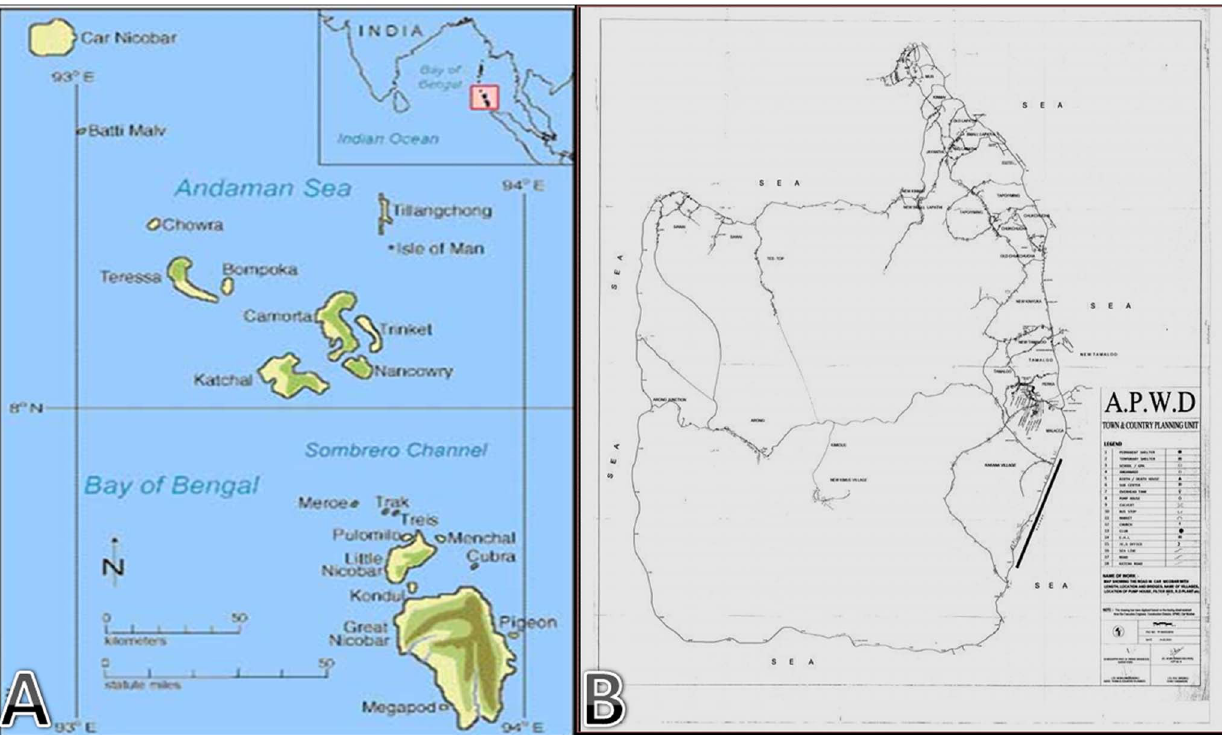
Figure 1. Location of the survey area. A) Map of Southern India (upper right inlet) showing location of Andaman & Nicobar Islands. Nicobar is the southernmost district of the Indian subcontinent. B) Detailed map of Car-Nicobar Island.